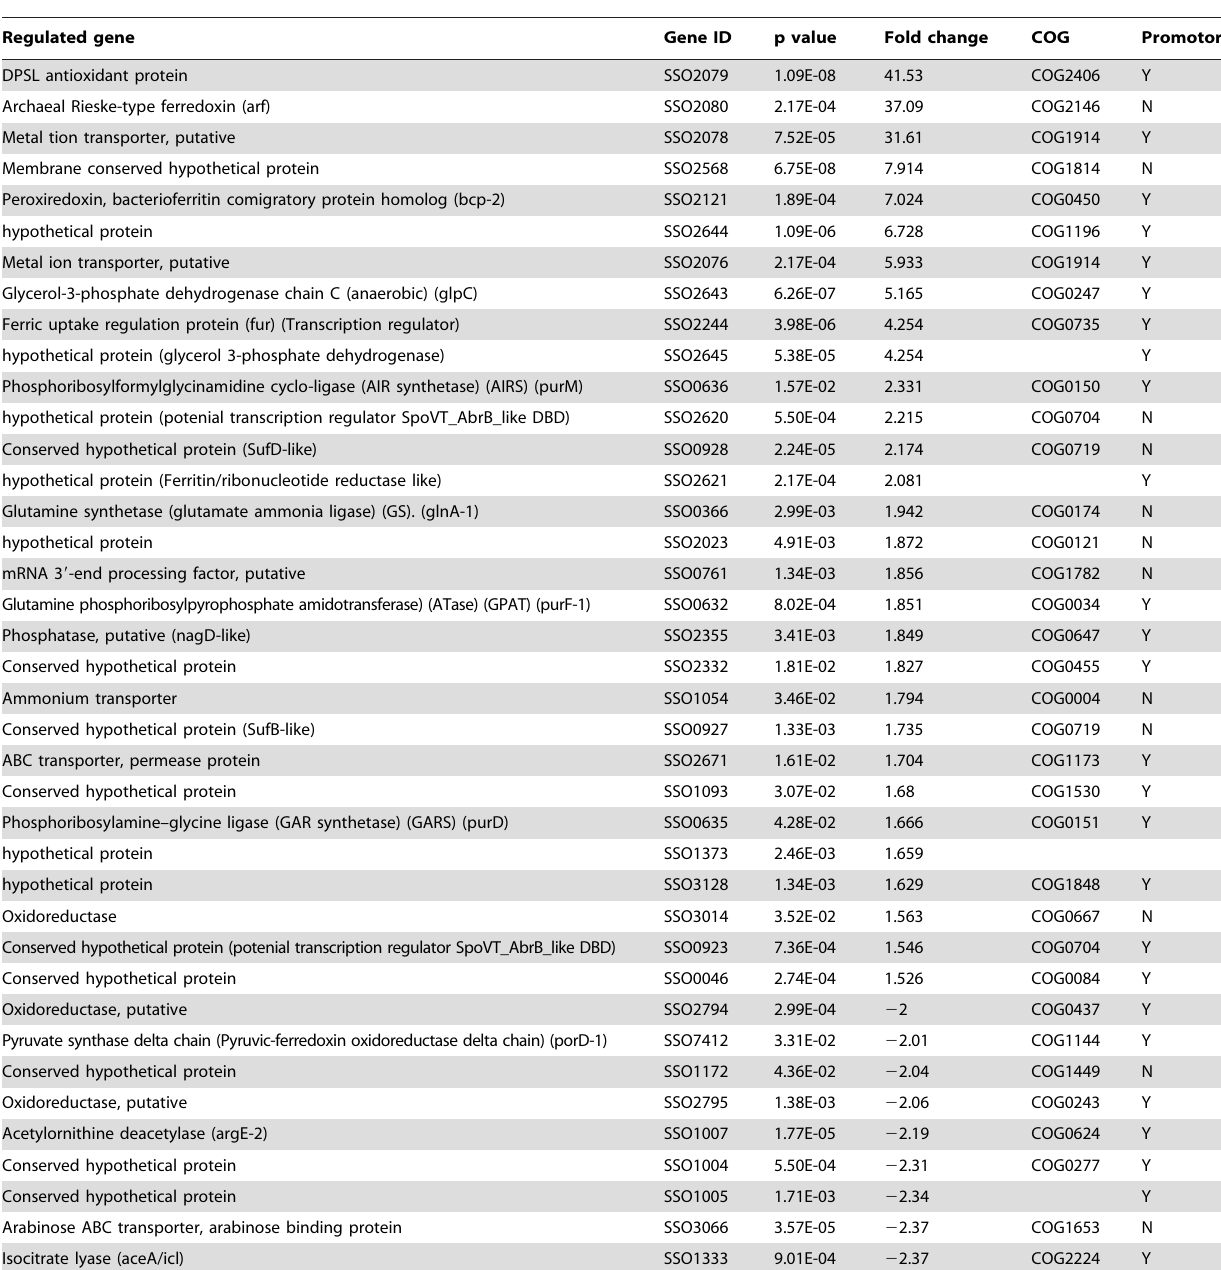
Table 1. Sulfolobus solfataricus transcriptionally regulated genes (for complete list see supplemental table S1).